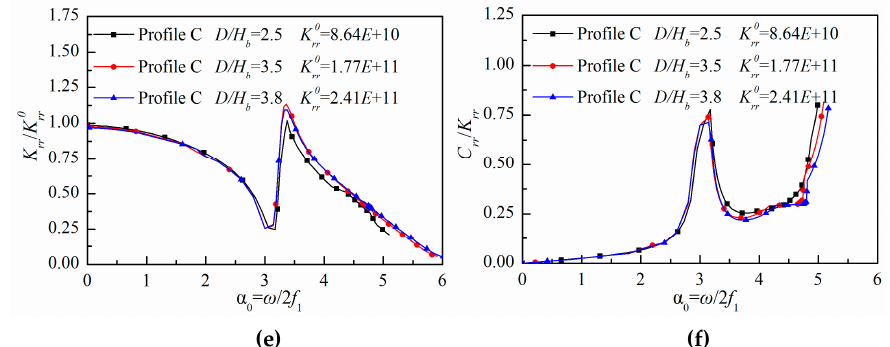
Figure 17. Variation of three dynamic impedance coefficients with respect to the dimensionless frequency under different diameter of WSBF embedded in Profile C: ( a ) Horizontal stiffness coefficient; ( b ) horizontal damping coefficient; ( c ) coupling stiffness coefficient; ( d ) coupling damping coefficient; ( e ) rocking stiffness coefficient; ( f ) rocking damping coefficient.